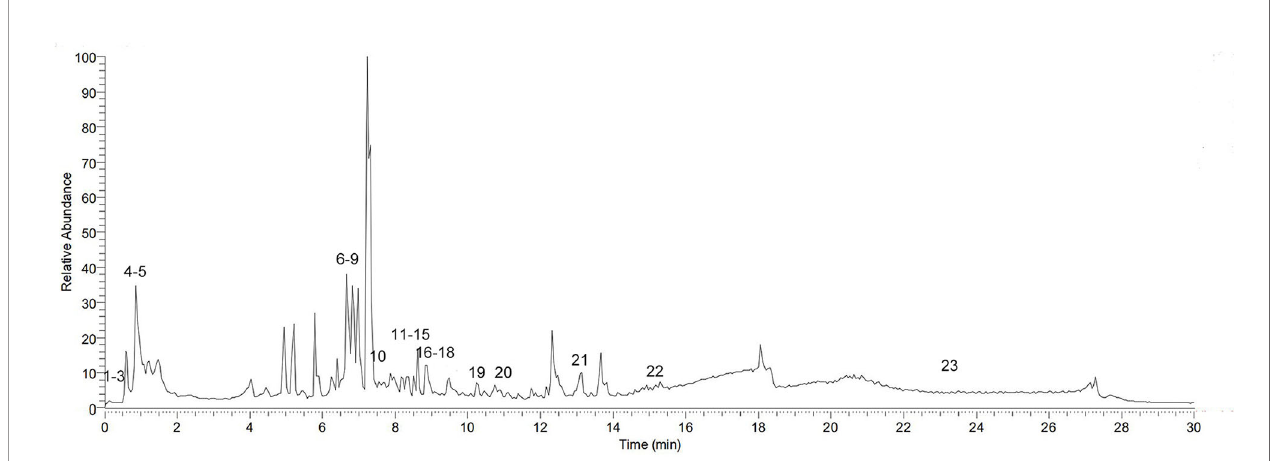
FIGURE 1 | Base peak ion (BPI) chromatogram of Zi Shen Huo Luo Formula (ZSHLF) in a positive ion fl ow diagram obtained by UPLC-MS/MS